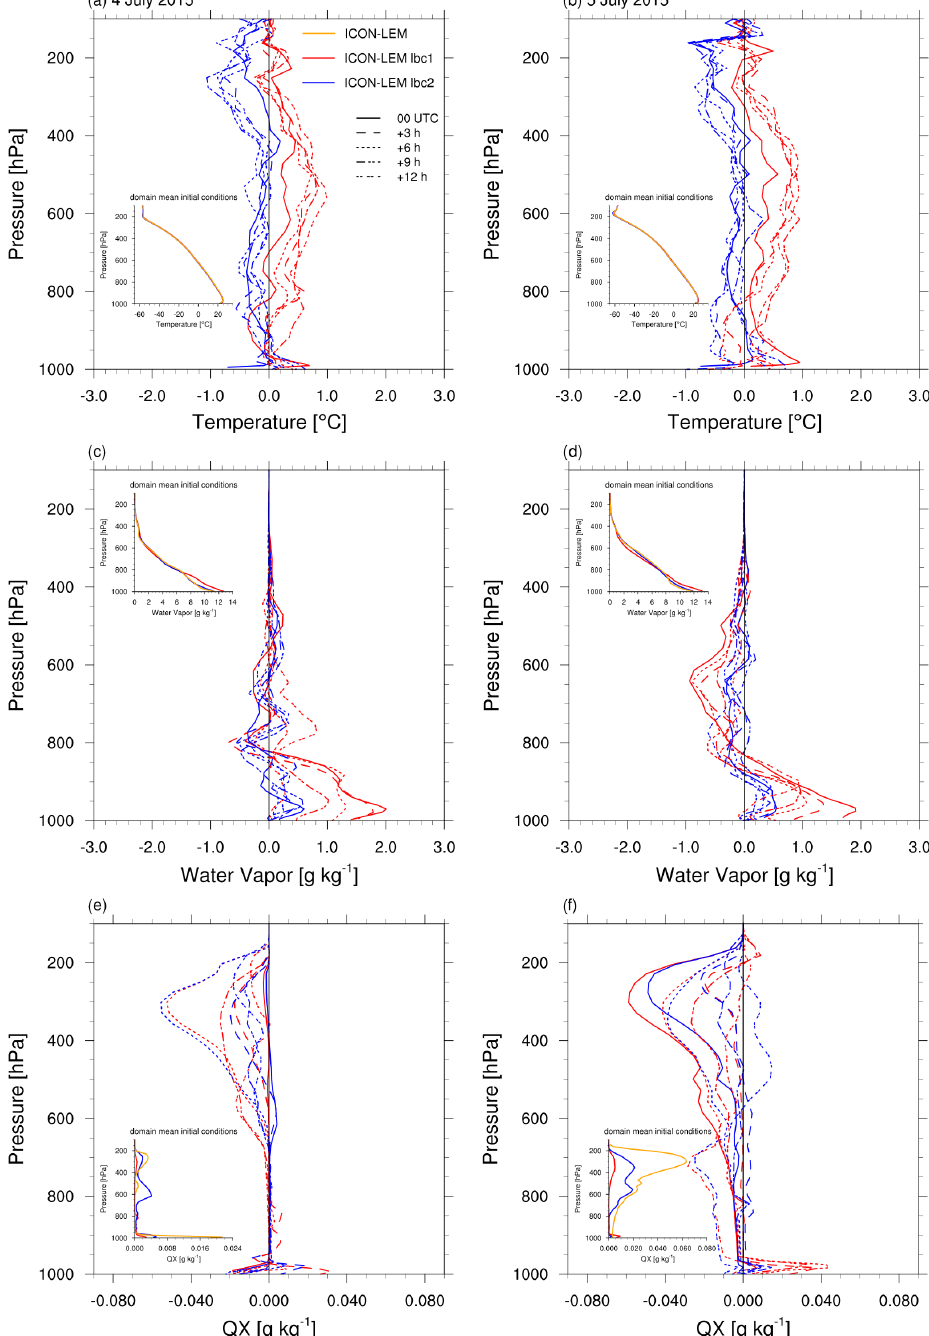
Figure A3. Initial and lateral boundary conditions used in Sect. 6.1 for temperature (a, b) , water vapor (c, d) , and total condensate, comprising cloud water, rain, ice, and snow (abbreviated as QX; e, f ). The vertical profiles show differences using the ICON-NWP (ICON-LEM lbc1 – red) and IFS (ICON-LEM lbc2 – blue) analysis compared to the default simulation using analysis data provided by COSMO-DE. All forcing data sets are remapped onto the high-resolution ICON-LEM DOM01 grid. Solid lines (00:00UTC) display a mean difference over the full domain, whereas the subsequent + 3, + 6, + 9, and + 12h differences are averaged differences over the 20km nudging zone at the domain edges, depicted with different line styles. The inlays show the mean initial (00:00UTC) absolute profiles for the full domain including the control simulation (ICON-LEM – orange line). The vertical axes of the inlays are the same as in the difference plots. x axis labels span the temperature range between − 60 and 10 ◦ C; for water vapor the range is 0 to 14gkg − 1 and for condensate 0 to 0.024gkg − 1